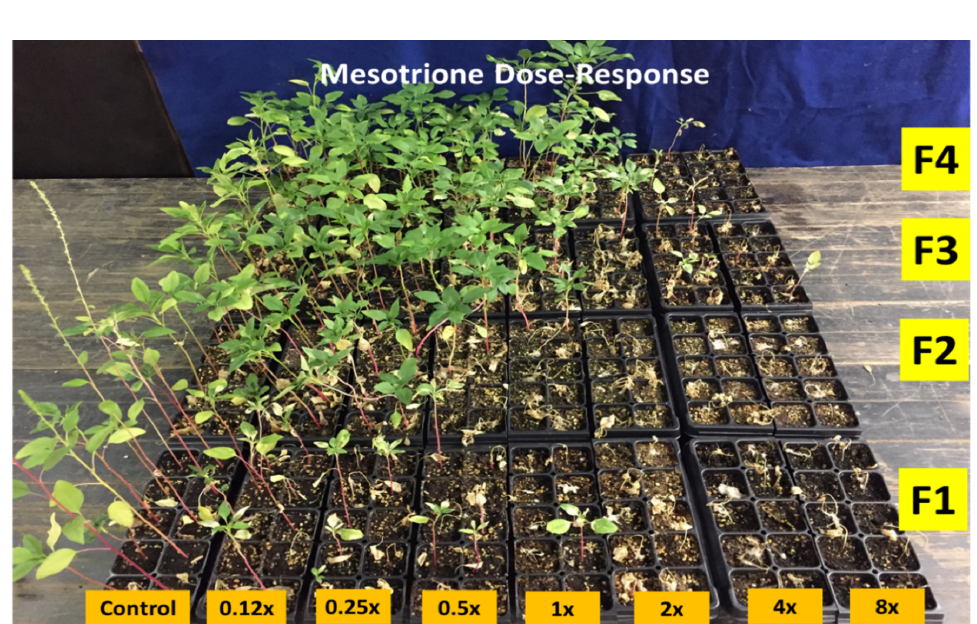
Figure 1. Generations of A. palmeri (F 1 , F 2 , F 3 , and F 4 ) treated with different mesotrione rates (x = 105 g ai ha − 1 ). Picture taken 3 weeks after treatment.